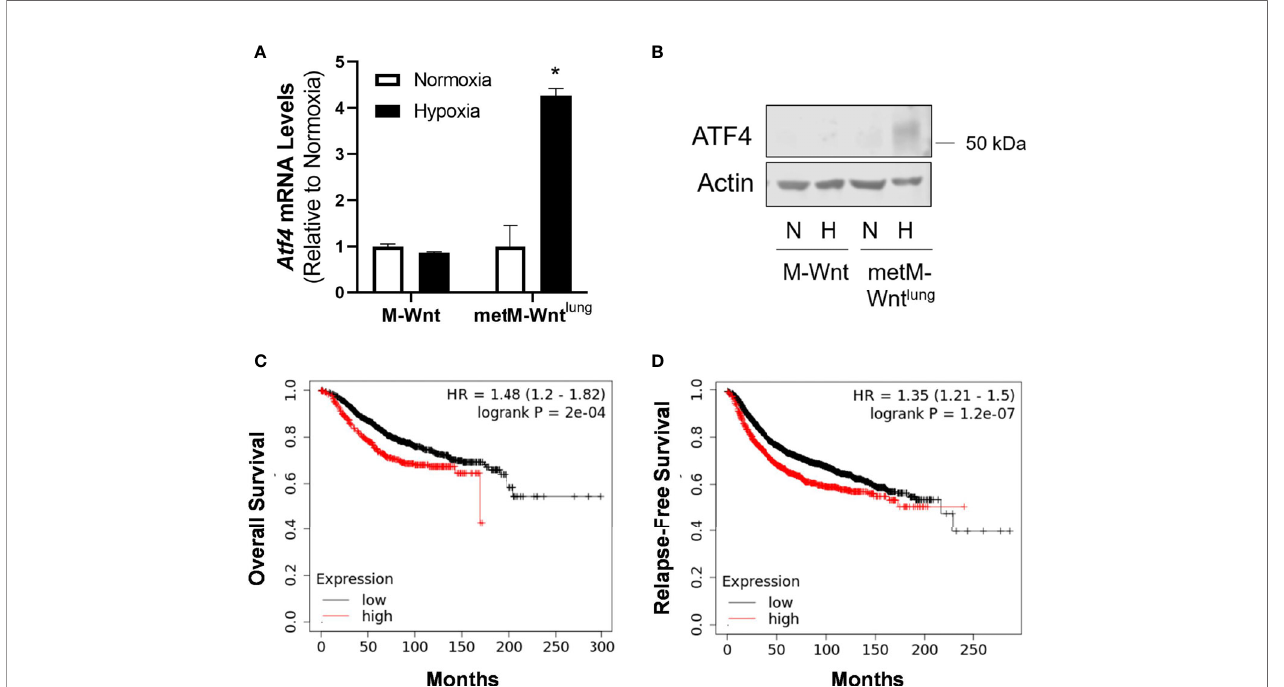
FIGURE 3 | Effect of hypoxia on ATF4 expression. mRNA (A) and protein (B) expression of ATF4 was determined using qRT-PCR and Western blotting in M-Wnt and metM-Wnt lung cells incubated in hypoxia (H) or normoxia (N) for 48 h. Results are expressed as mean + SEM. Asterisk (*) indicates P < 0.05 relative to normoxia, n=3. Overall survival (C) and relapse-free survival (D) of breast cancer patients with high (red) or low (black) expression of ATF4, where patient data are split by upper quartile (compared to lowest three quartiles) of ATF4